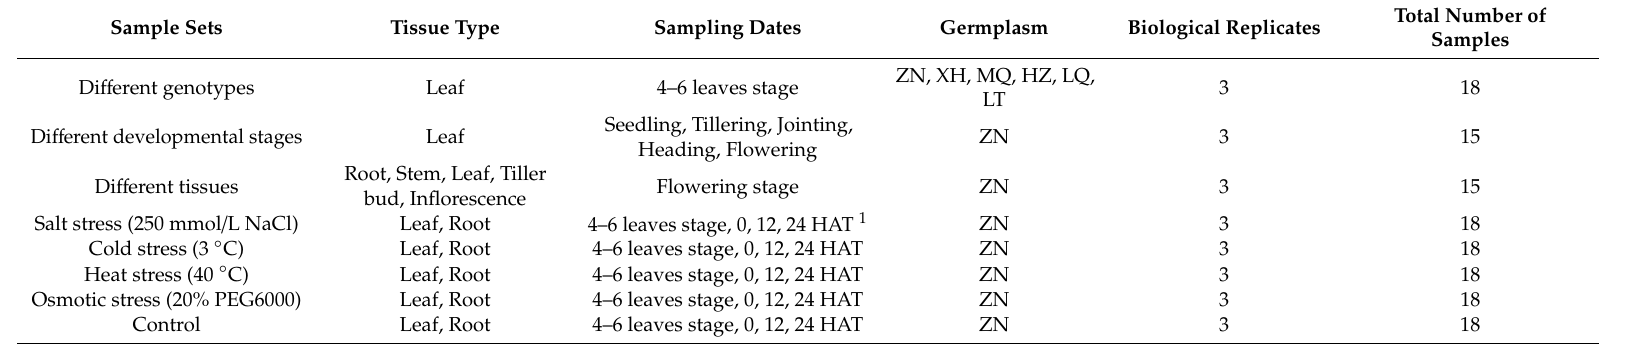
Table 1. Experimental sets in the present study.